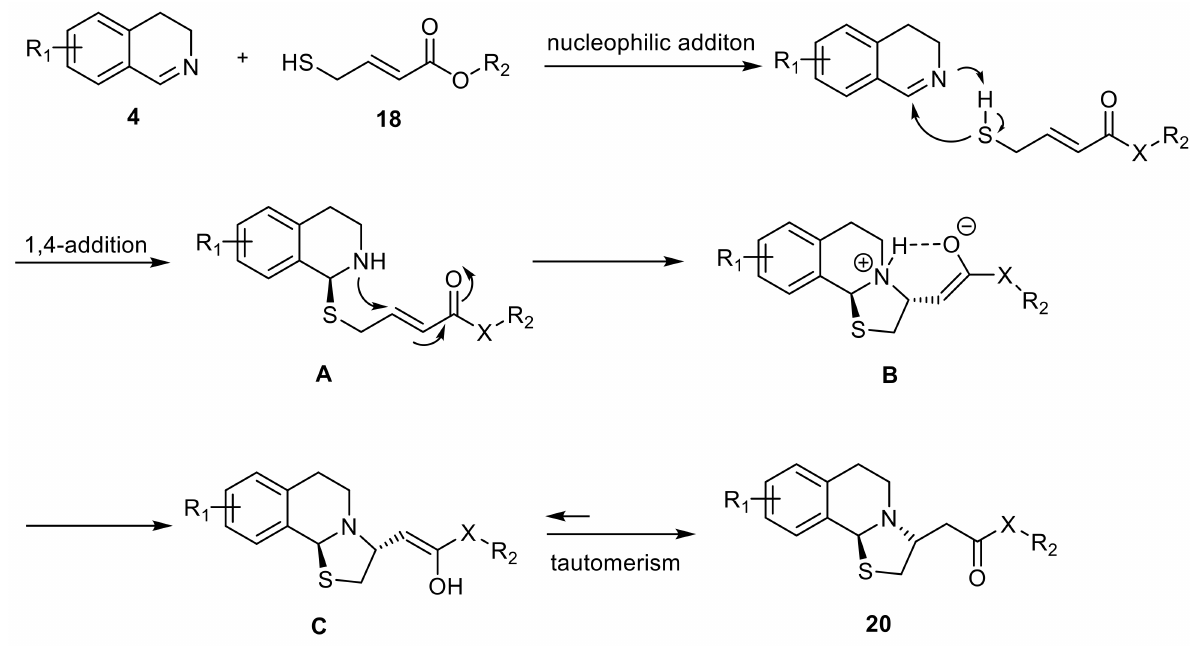
Figure 3. The plausible mechanism for the formation of 20